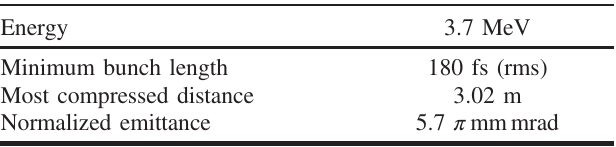
TABLE V. Expected electron beam from the fabricated ECC-rf gun at Waseda accelerator